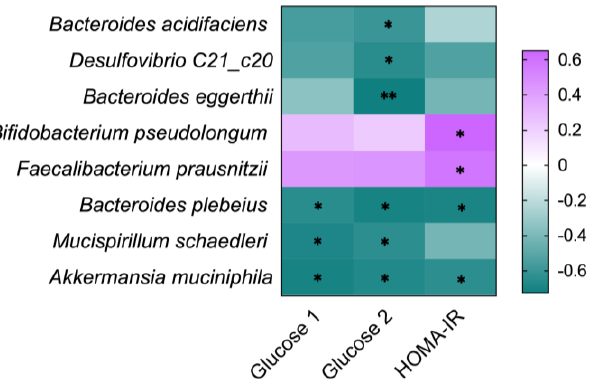
Figure 7. Relationship between intestinal microbiota at species level and diabetes-related indexes, including fasting blood glucose at week 9 (Glucose 1), blood glucose at time point of 15 min of OGTT (Glucose 2), and HOMA-IR. The green and purple represent negative and positive correlation, respectively. * p < 0.05; ** p <